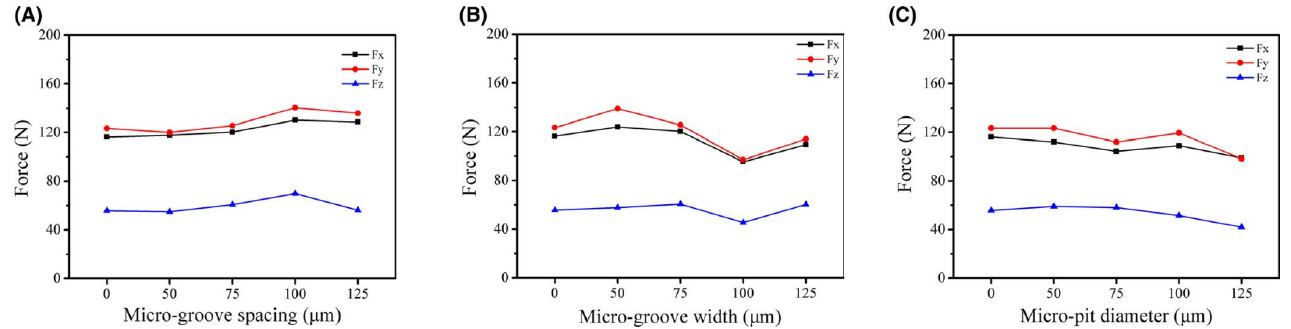
Figure 17. Cutting force of the three tools at the same speed of 120 m/min: ( A ) MG-S; ( B ) MG-W; and ( C ) MP-D [75].